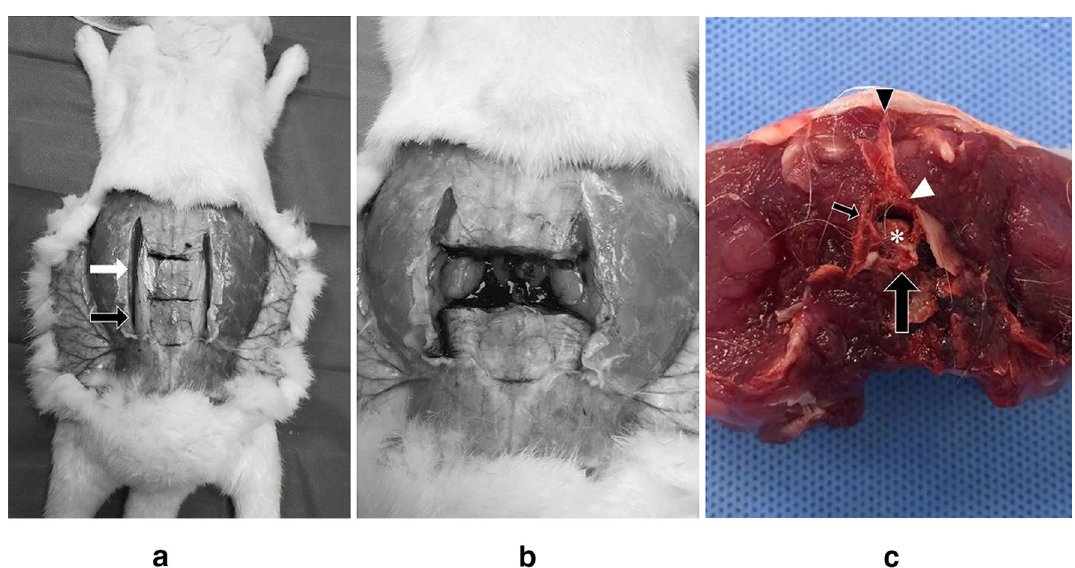
Figure 4. Tissue harvesting. ( a ) The euthanized rabbit is placed in prone position. Two consecutive vertebrae consisting of the ESI level (black arrow) and the level just above (white arrow) are harvested simultaneously. ( b ) A single vertebral segment was harvested. ( c ) Axial view of the harvested vertebral segment shows potential epidural space (white arrowhead) just beneath the bony neural arch (small black arrow). The neural spine (black arrowhead) of rabbit vertebra was located on the dorsal side, and the vertebral body (large black arrow) is located on the ventral side. The spinal cord (asterisk) was visualized within the neural